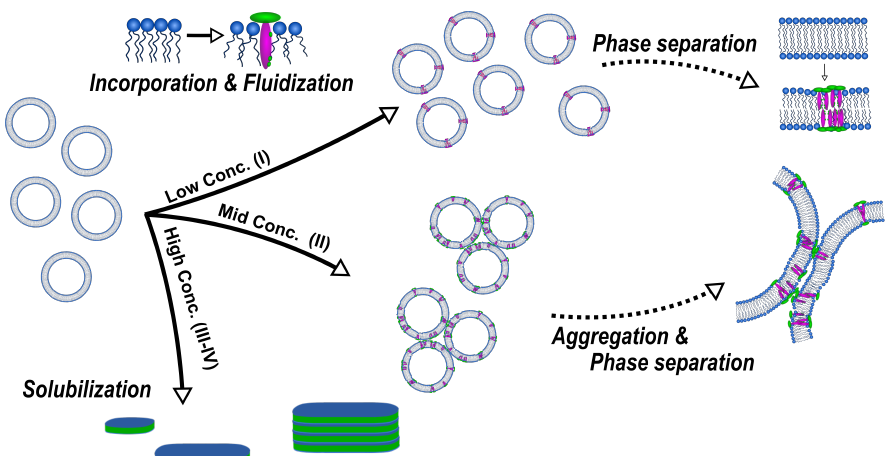
Figure 8. Summary of β -aescin-DMPC interactions depending on saponin concentration. The incorporation of β -aescin molecules into the DMPC bilayer increases the bilayer fluidity and β -aescin molecules phase-segregate into saponin-rich and saponin-poor domains in the membrane. With increasing β -aescin concentration, vesicles start to become unstable in solution and agglomerate due to the formation of larger domains. At β -aescin concentrations far above cmc of β -aescin (high conc. regime (III–IV)) the DMPC membrane is solubilized by the saponin molecules and discoidal bicelles form which are tunable in size by composition and temperature. Adapted with permission from Sreij et al. [46], ©2017 American Chemical Society.